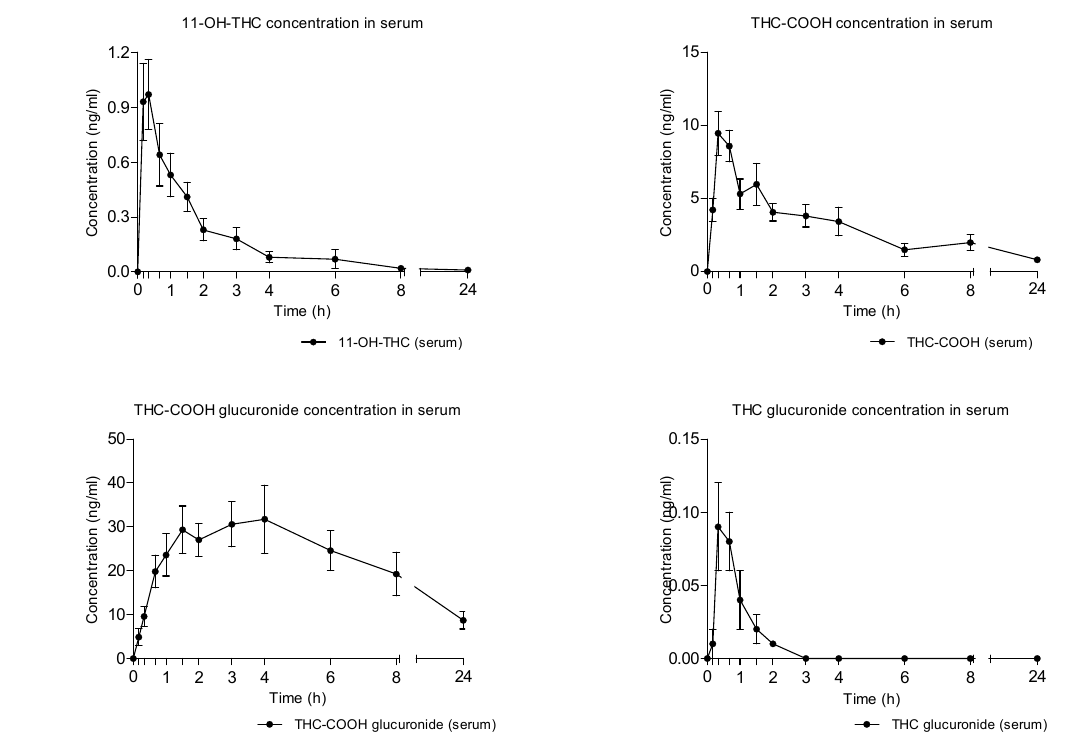
Pharmaceuticals 2021 , 14 , x FOR PEER REVIEW Figure 4. Mean time-course of THC metabolites concentrations in serum following the administration of vaporized cannabis.